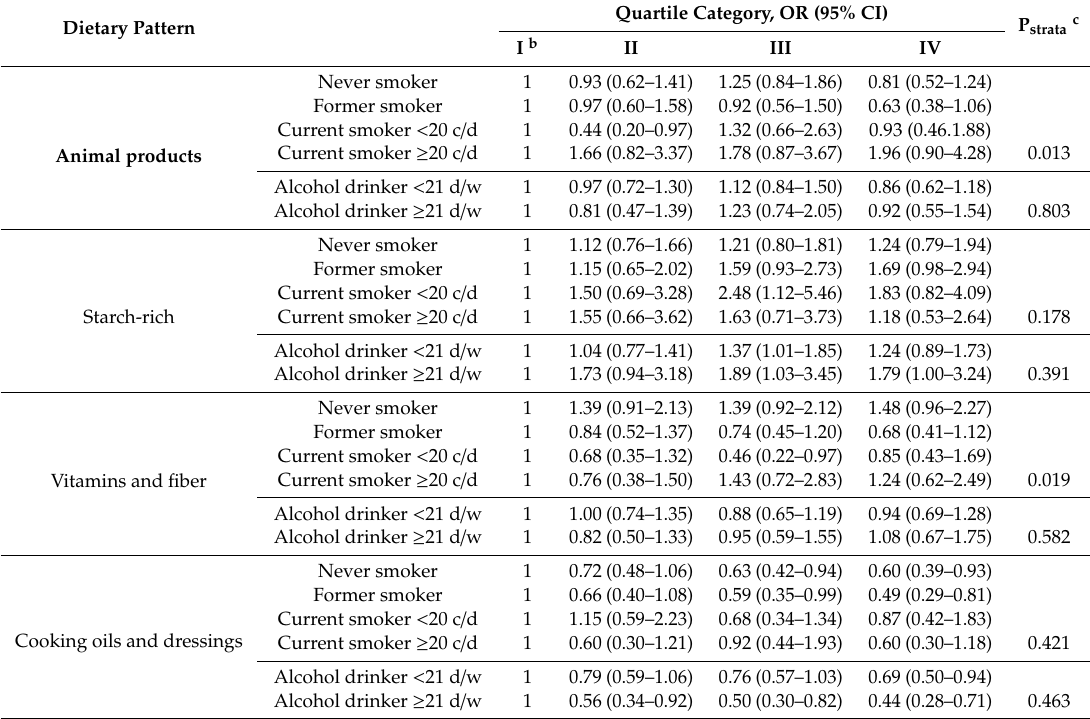
Table 7. Odds ratios (ORs) a of renal cell carcinoma and corresponding 95% confidence intervals (CIs) on quartiles of factor scores in strata of tobacco smoking and alcohol